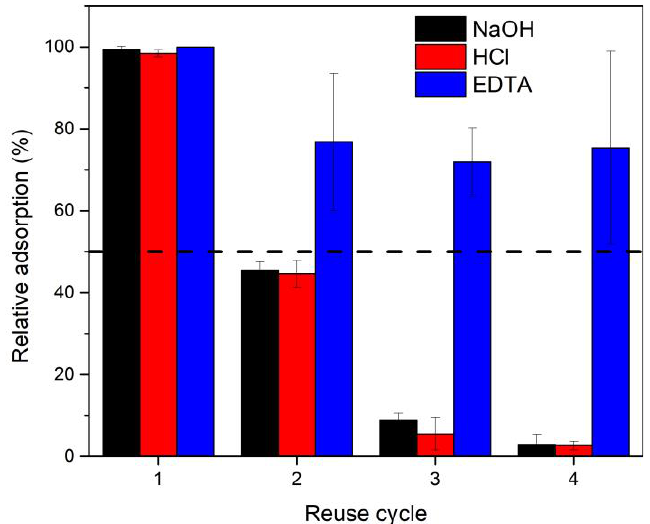
Figure 4. Consecutive cycles of Hg 2+ adsorption of the magnetic composite after 12 h at 25 °C, pH 5, and 200 rpm. Amounts of 0.1 M NaOH (black), 0.1 M HCl (red), and 2 M EDTA (blue) were used to rinse the magnetic composite in each cycle. Each reaction cycle lasted 12 h and the adsorption capacity in the first cycle was set as 100 % (mean ± SD, n = 3). Table 3. Comparison of Hg 2+ removal using different adsorbent materials.